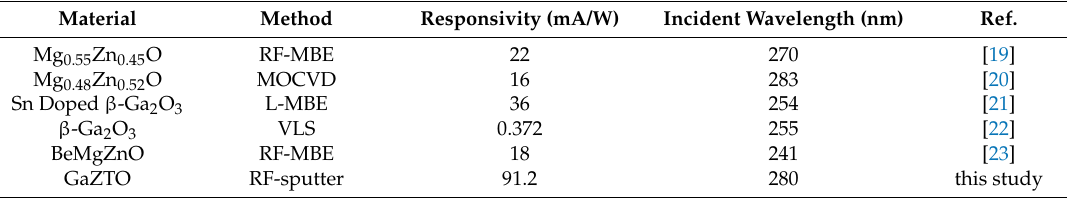
Table 4. Responsivity of photodetectors fabricated with different materials using various methods. It is noted that RF-MBE stands for radio-frequency plasma assisted molecular beam epitaxy, MOCVD for metal-organic chemical vapor deposition, L-MBE for laser molecular beam epitaxy, and VLS for vapor-liquid-solid